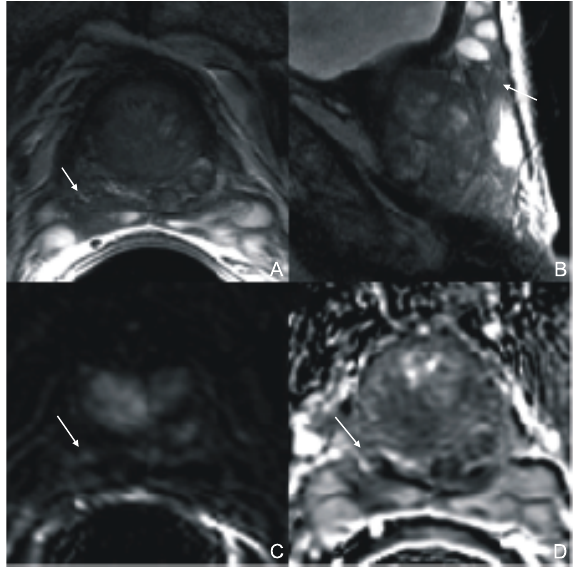
Figure 3 Multiparametric prostate MRI [(A) axial T2-weighted; (B) sagittal T2-weighted; (C) dynamic contrast-enhanced subtraction; (D) apparent diffusion coeffificient (ADC) map (b = 500 s/mm2 )] of a 60-year-old man with biopsy-proven prostate cancer (Gleason 4 + 3 = 7) and rapidly rising prostate-specifific antigen (PSA). MRI shows signal abnormalities in the medial part of the seminal vesicle, suggestive of seminal vesicle invasion (arrows) (Reprinted with permission from